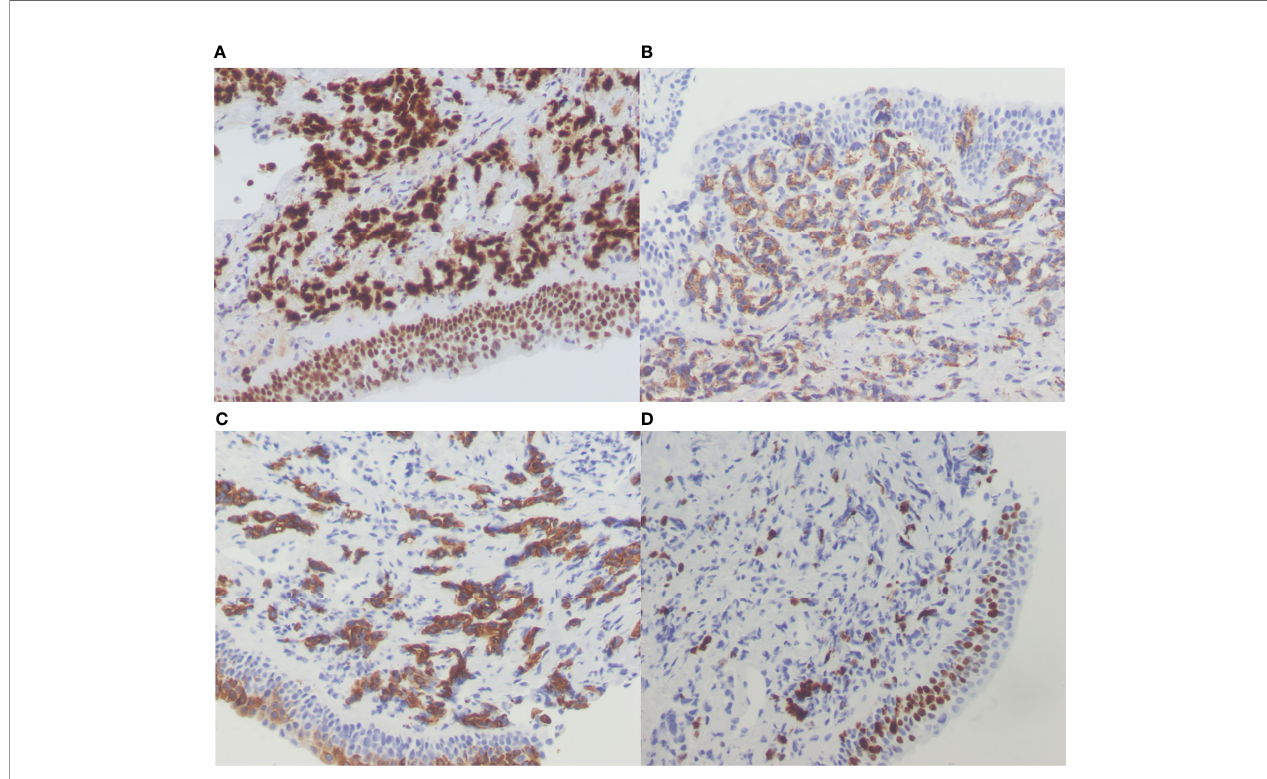
FIGURE 2 | Histological fi ndings. Immunohistochemistry was positive for (A) TTF-1 (200×); (B) Napsin A (200×); (C) CK7 (200×); and (D) Ki67